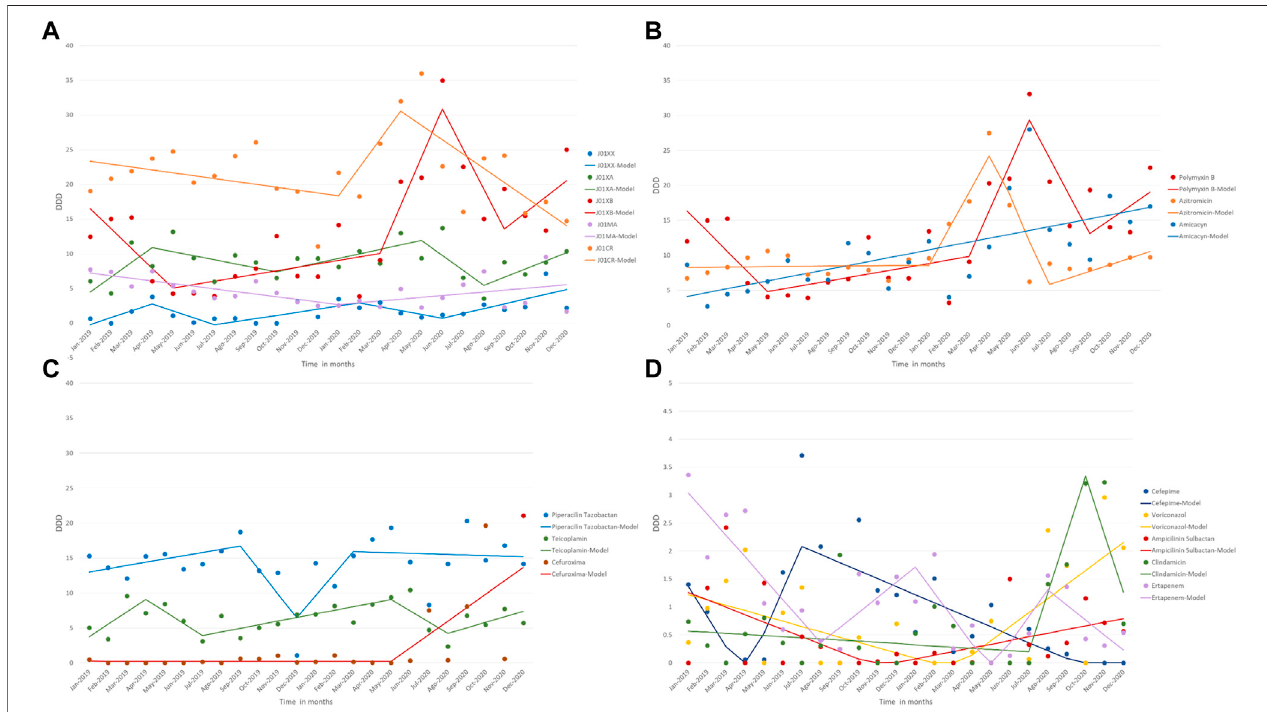
FIGURE 2 | Antibiotic consumption (DDD) for (A) ATC groups J01XX, J01XA, J01XB, J01MA, J01CR, (B) Polymyxin B, Azitromicin and Amicacyn (C) Piperacillin Tazobactan, Teicoplamin and Cefuroxima and (D) Cefepime, Voriconazole, Ampicilinin Sulbactam, Clindamycin and Ertapenem from January 2019 to December 2020 (Rio de Janeiro,